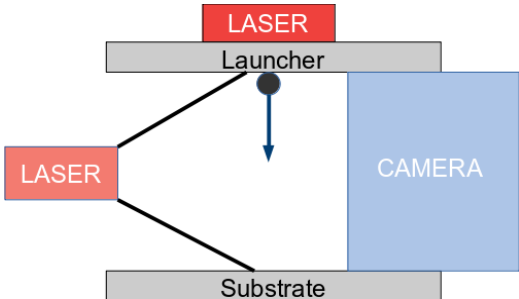
Fig. 4. Schematic view of the LASHPOL platform: the laser on the top generates the shock, the one on the left illuminates flying